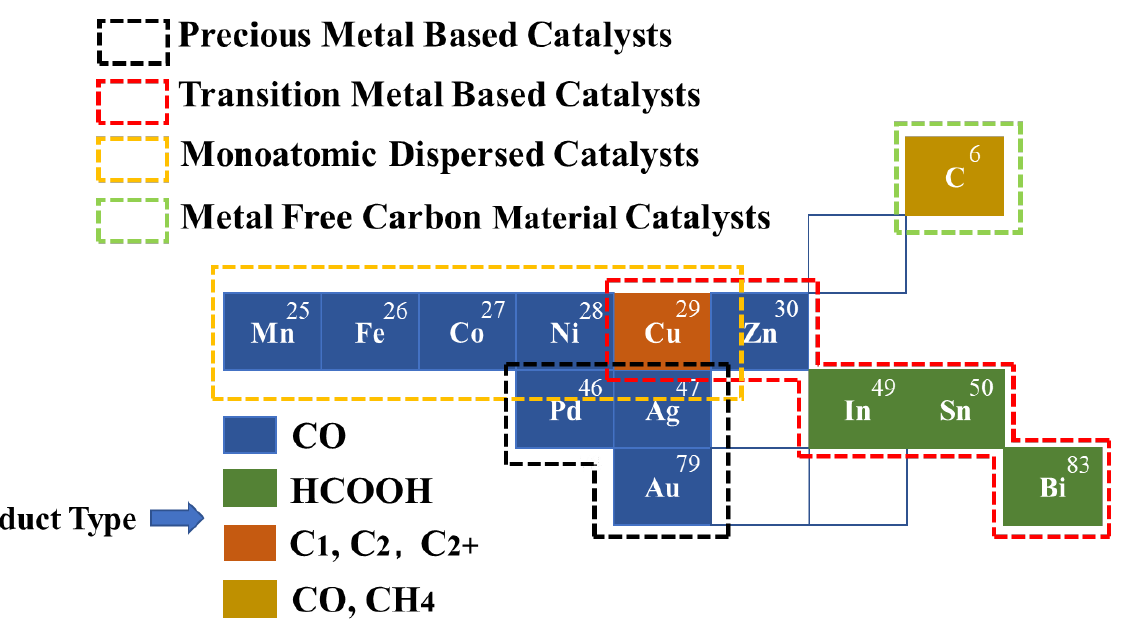
Figure 4. Classification of catalysts and product types.